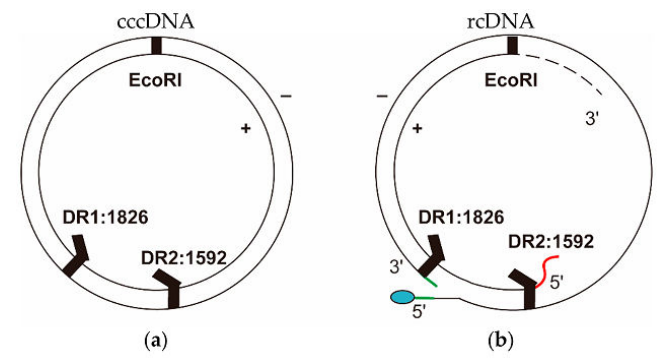
Figure 2. Structure of cccDNA and the HBV genomic rcDNA: ( a ) cccDNA has two complete strands: the minus-strand on the outer side and the plus-strand on the inner side. There are two direct repeats (DRs) at nucleotide (nt) 1826 and 1592 (gi: 4323196), and the position of origin is at the EcoRI site [64]; ( b ) rcDNA has a complete minus strand with a nine-base terminal redundancy (green line) and a terminal protein polymerase attached to the 5 (cid:48) -end (blue oval). The plus strand has a defined 5 (cid:48) -end with an RNA primer (red line) but a variable 3 (cid:48) -end (dashed